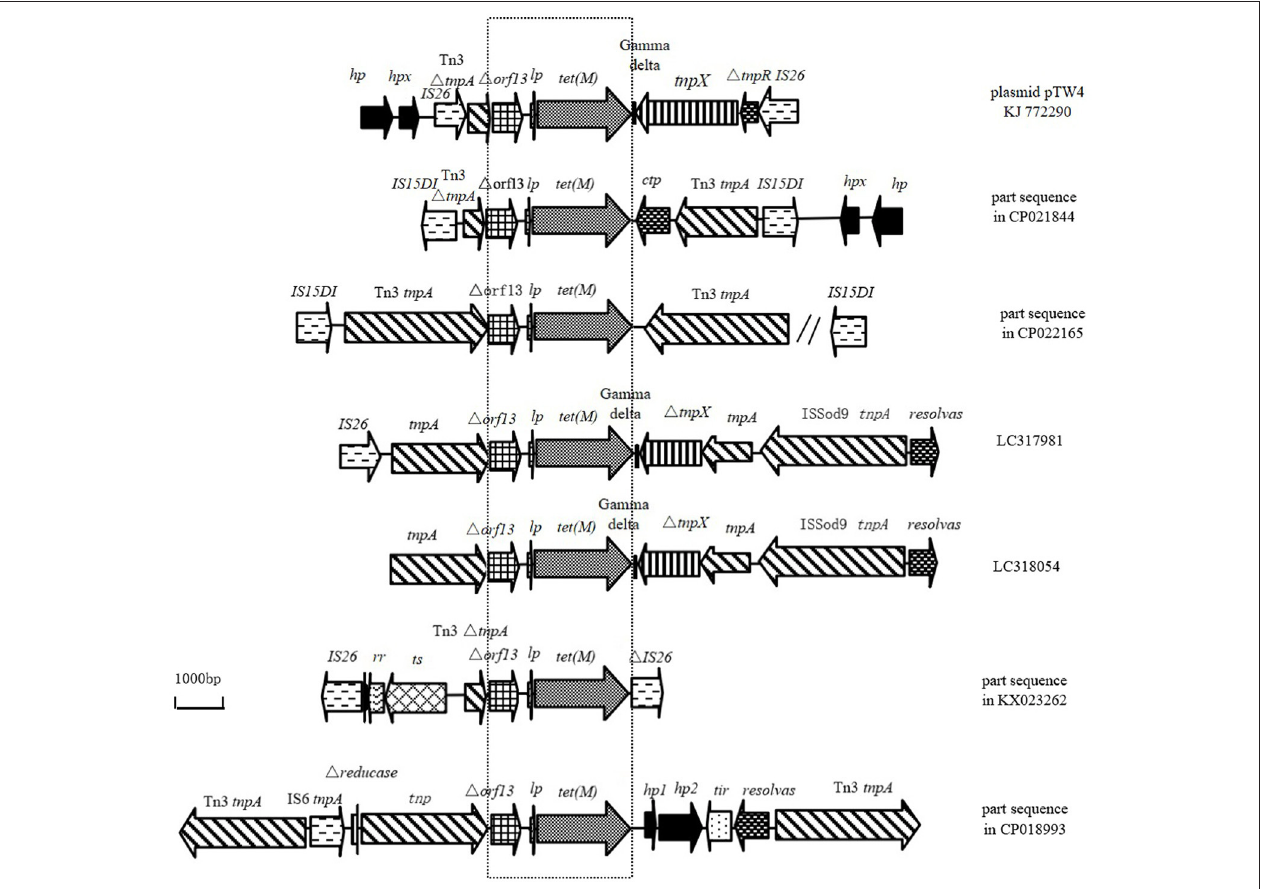
FIGURE 3 | Structural features surrounding the sequence of 1 orf13 + lp + tet (M) in KJ772290 compared to other sequences deposited in GenBank. (Similar regions are indicated by dotted lines; hp , gene encoding hypothetical protein; hpx , gene encoding putative protein X; lp , gene encoding TetM leader peptide; ctp , gene encoding conjugative transfer protein; symbol “//” the sequence of 13,102 bp between Tn3 tnpA and IS15D1; rr , gene encoding RadR regulator; ts, gene encoding chromate